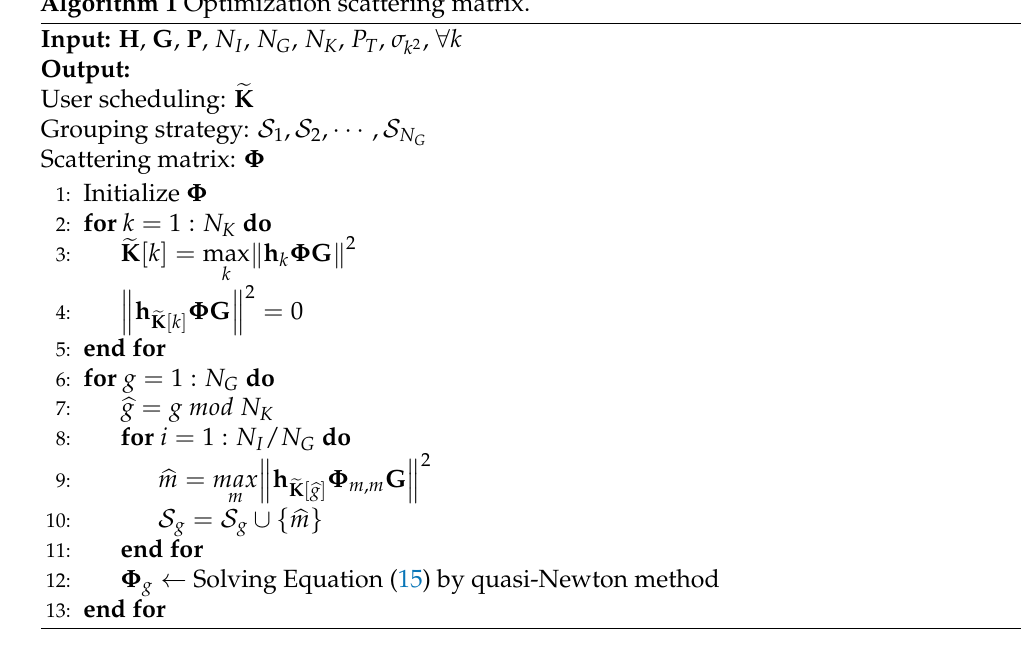
Algorithm 1 Optimization scattering matrix.